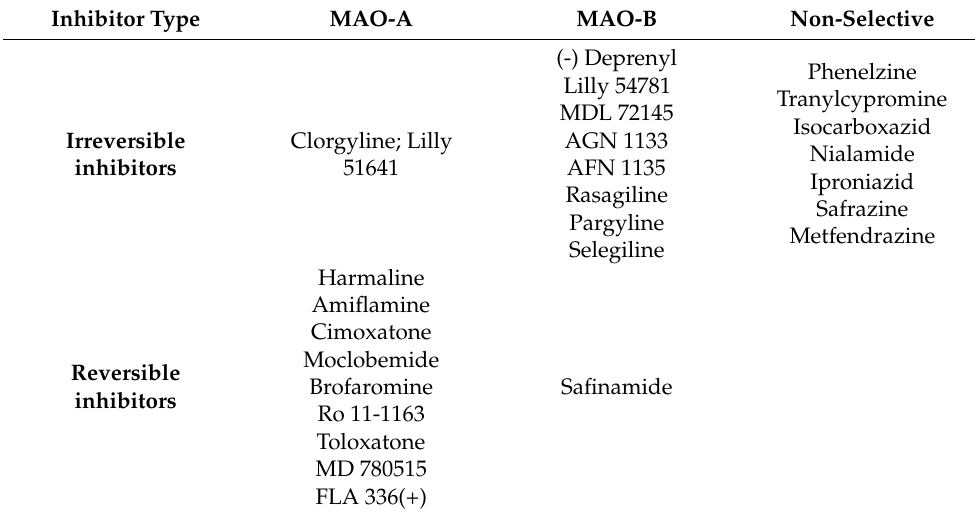
Figure 3. Chemical structure of selected MAO inhibitors. Table 1. Monoamine oxidase inhibitors (MAOIs) classified on the basis of their selectivity [28,29].